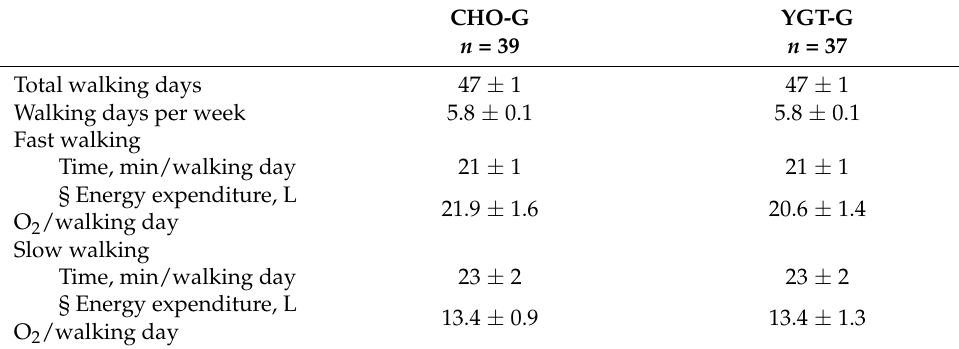
Table 3. Training achievements for CHO-G and